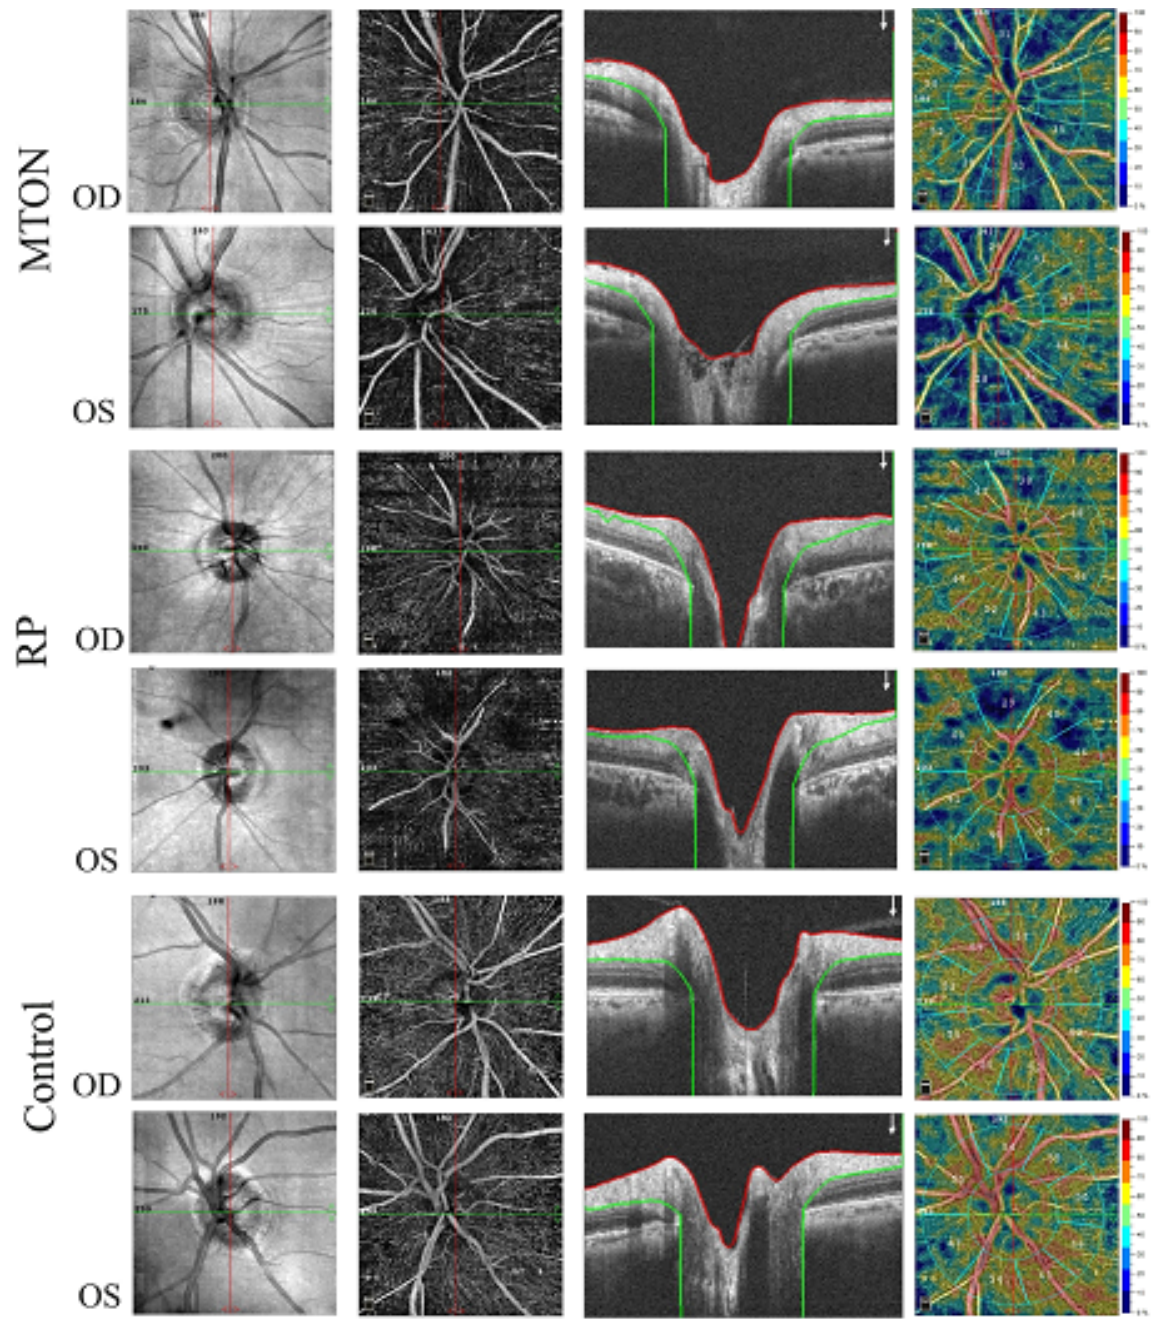
Figure 1. Peripapillary OCT-A images in MTON compared to RP and a healthy individual. From left to right, SLO images, En-face OCT-A (ILM-NFL), corresponding B-scan, vessel density map in MTON, RP patient, and a healthy control. Vessel density analysis has been done between two slabs shown in